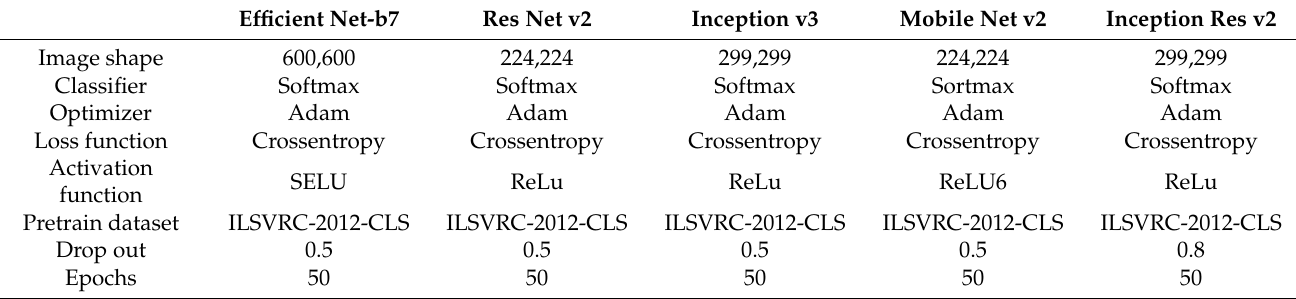
Table 2. Hyperparameter used to examine the models based on CNN.